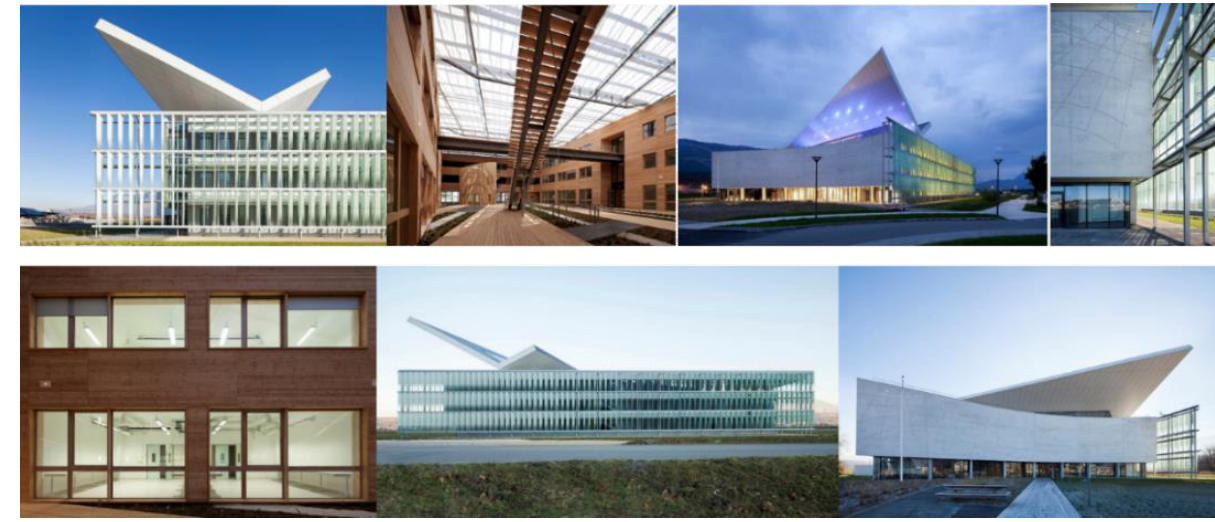
Figure 4. The Helios building.